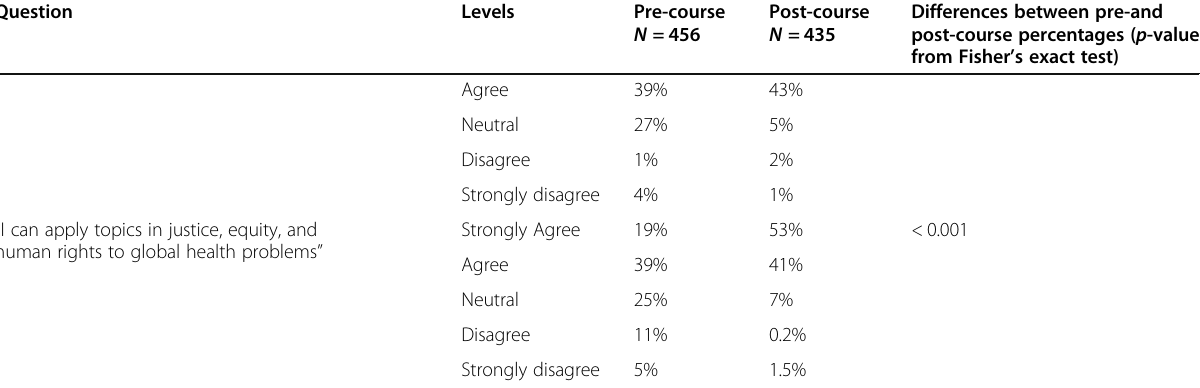
Table 2 Results of self-perceived global health competencies in the pre and post-course survey (Continued)